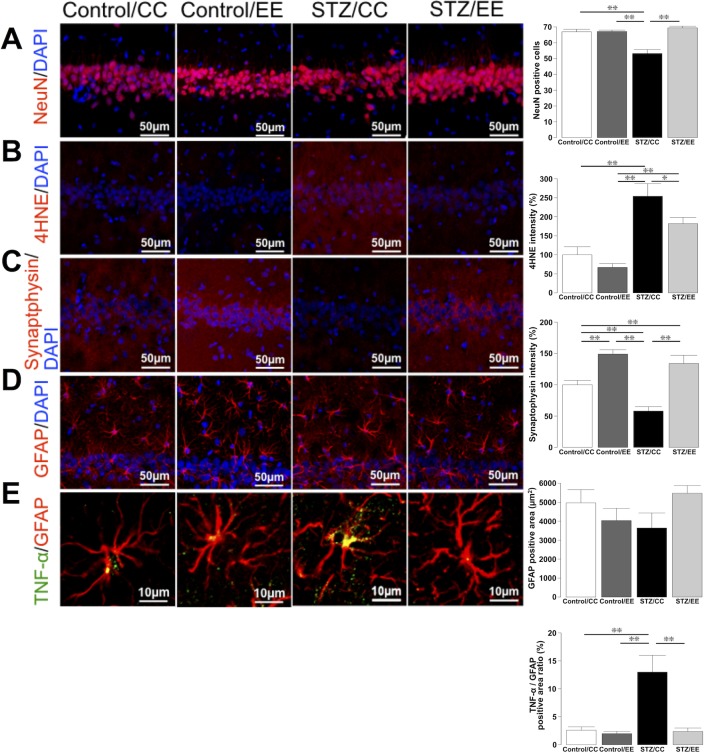
Immunohistochemical analysis of the rat hippocampal CA1 region.(A) The number of NeuN-positive cells in the hippocampal CA1 region. (B) The intensity of the 4HNE (4-hydroxynonenal)-positive area. (C) The intensity of synaptophysin staining. (D) The area of GFAP positivity. (E) The ratio of the tumor necrosis factor (TNF)-α positive area to the GFAP-positive area. (A-E) *P < 0.05, **P < 0.01, one-way ANOVA, Bonferroni post-hoc test. Values are means ± standard error, n = 6-7/group.